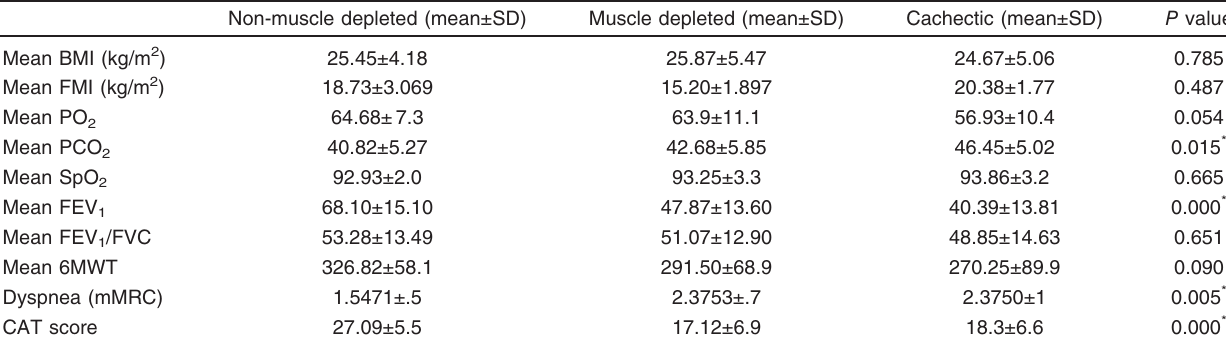
Table 6 Statistical comparison between non-muscle depleted, muscle depleted, and cachectic groups after pulmonary rehabilitation program Non-muscle depleted (mean±SD) Muscle depleted